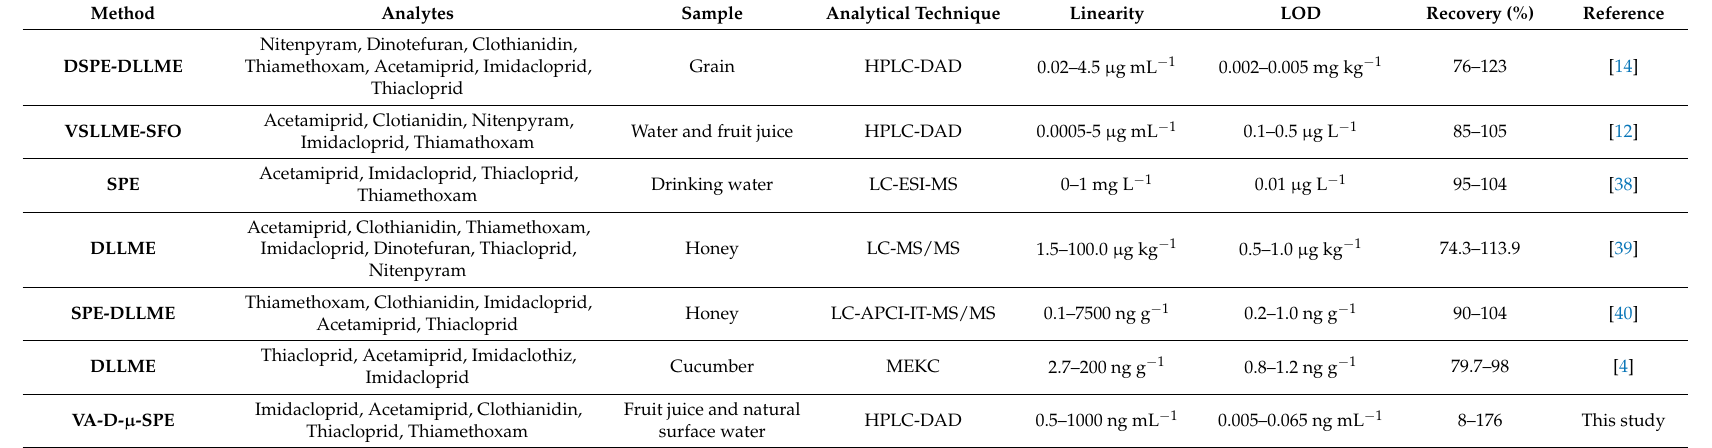
Table 3. Comparison of the proposed VA-d- µ -SPE method with other sample preparation methods for the determination of